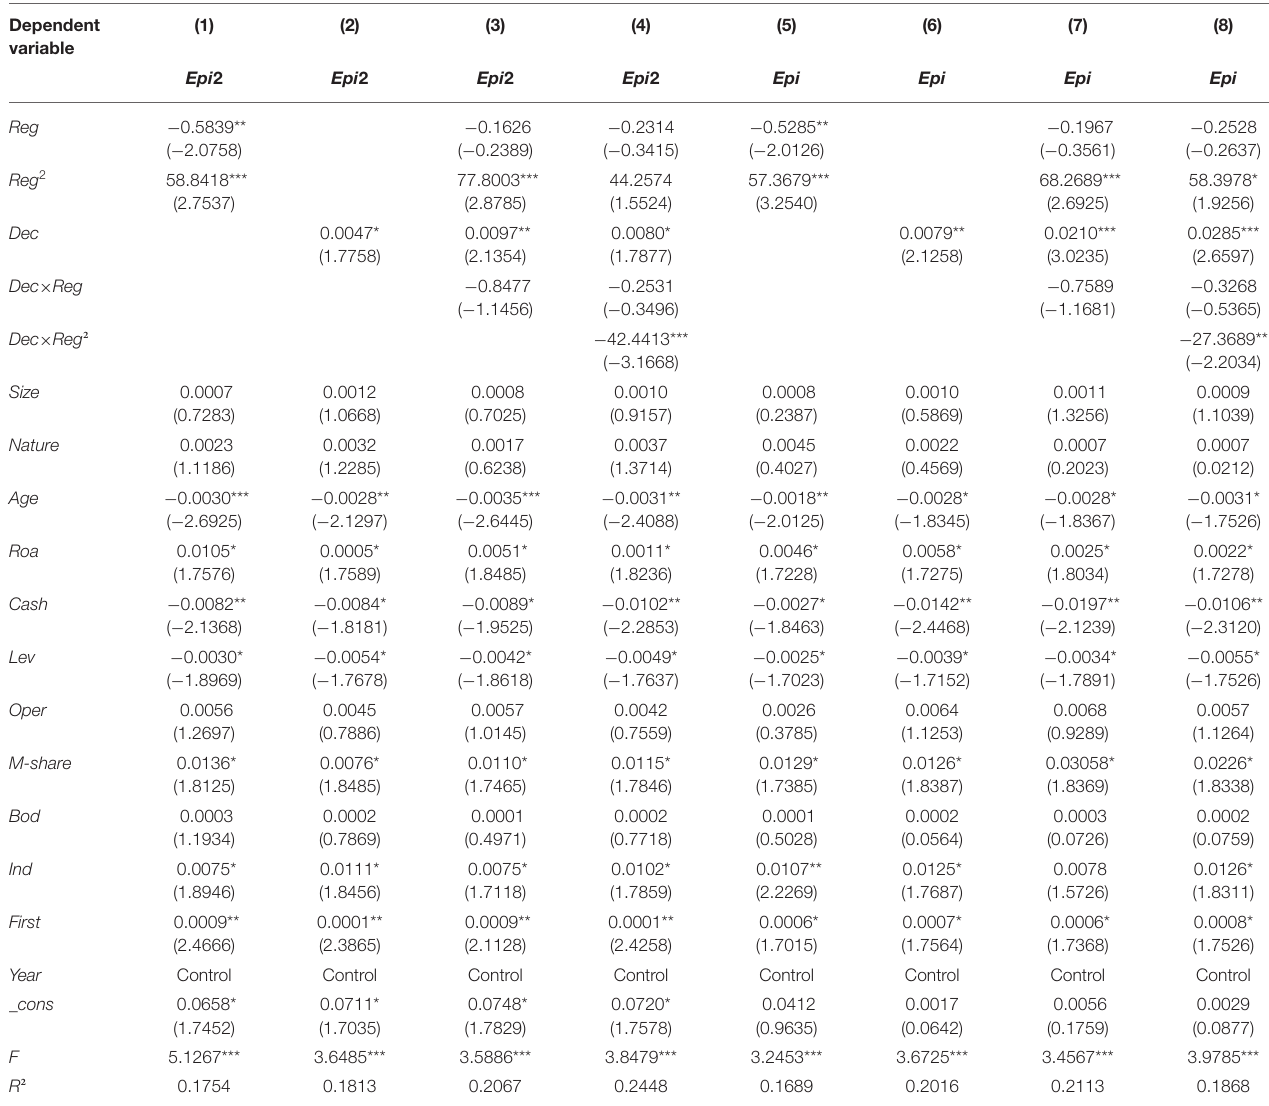
TABLE 5 | Robustness